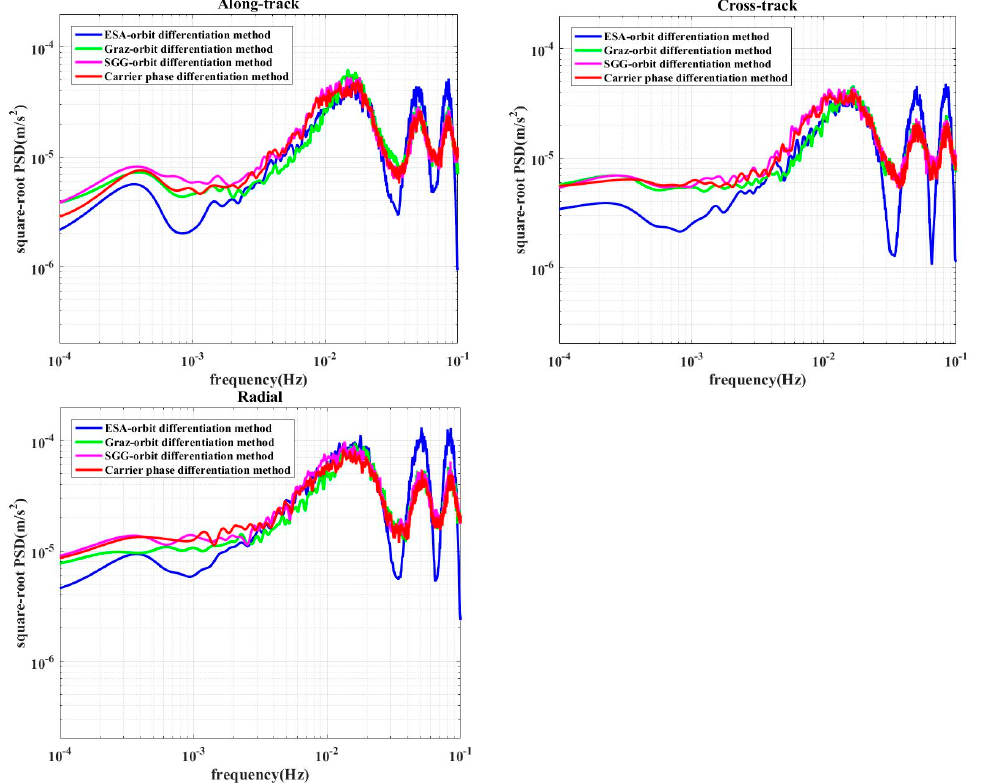
Figure 2. PSDs of the residual accelerations derived by the four di ff erent methods. ( Top-left ) Along-track; ( Top-right ) Cross-track; ( Bottom ) Radial (unit: m / s 2 / Hz 1 / 2 ).